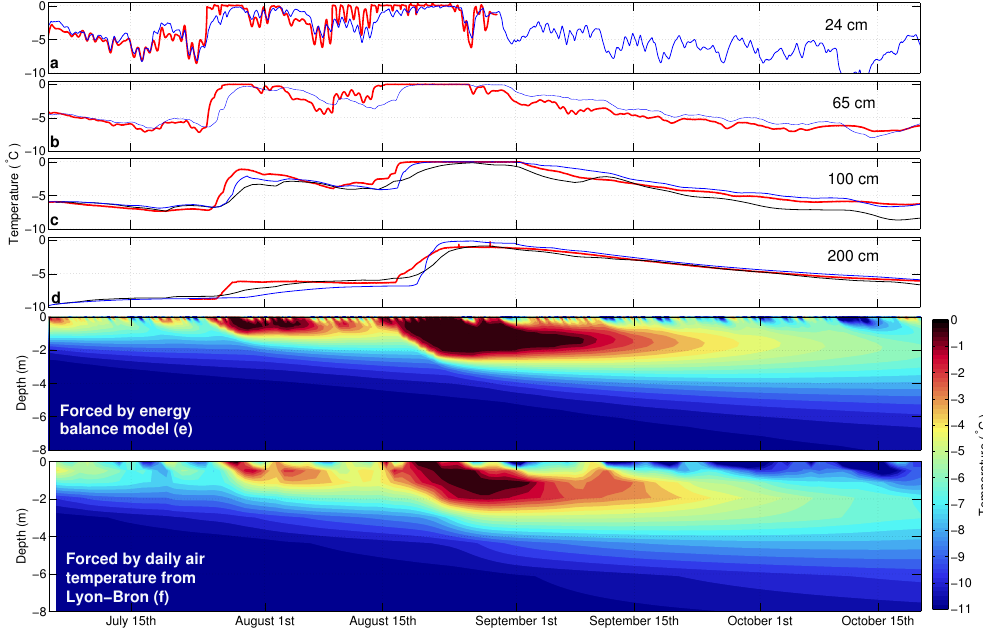
Fig. 6. Measured (red line) and modeled (blue and black lines) firn temperature at different depths (a, b, c, d) . Modeled firn subsurface temperature during summer 2012 using the energy balance model at a 30min time step ( e , blue line in a, b, c, d ) compared to modeled temperature using the Lyon–Bron temperature at a daily timescale ( f , black line in c, d